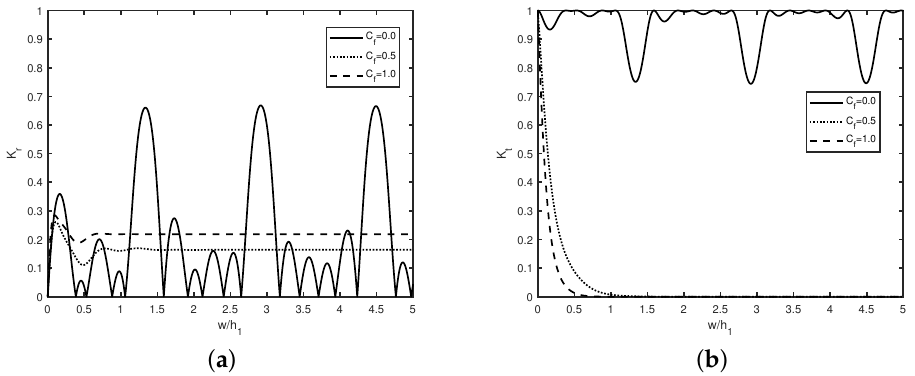
Figure 12. Variation of ( a ) reflection coefficient K r , and ( b ) transmission coefficient K t versus break- water width w / h 1 for different values of C f with breakwater width w / h 1 = 1.0, h 2 / h 1 = 0.5 and N =